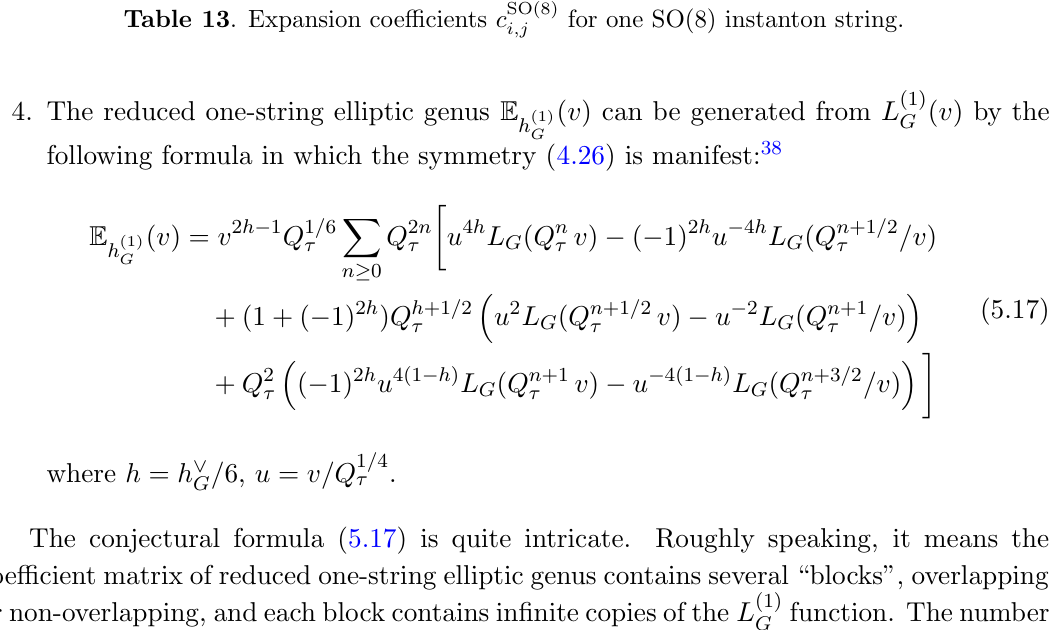
Table 13 . Expansion coe(cid:14)cients c SO(8)